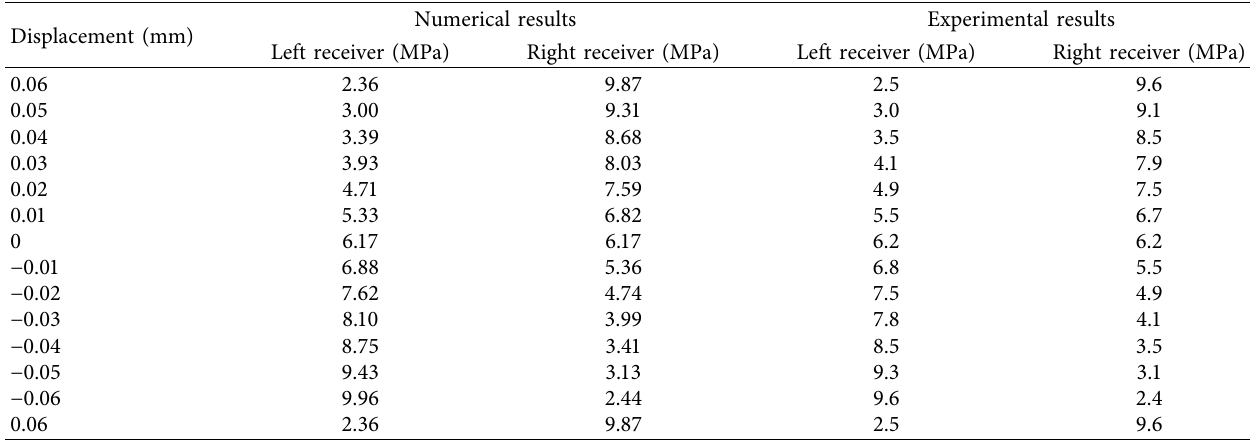
Table 2: Receiver pressures under different deflector